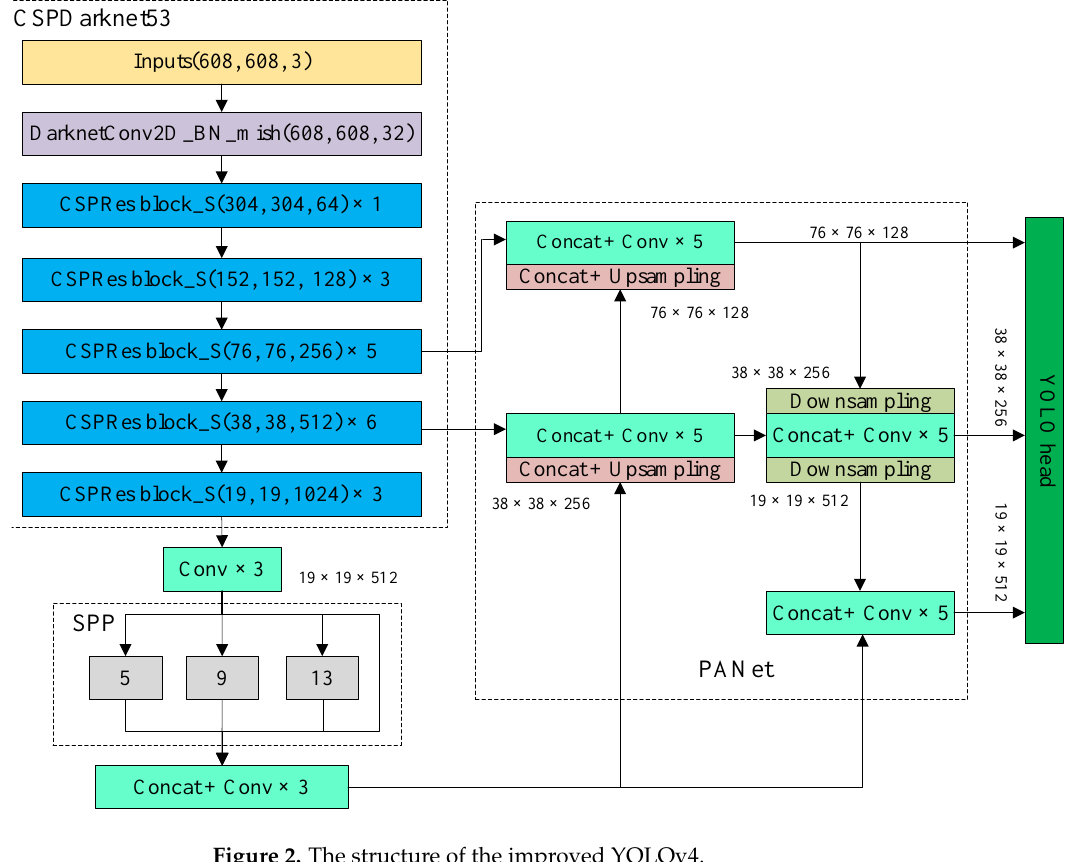
Figure 2. The structure of the improved YOLOv4.